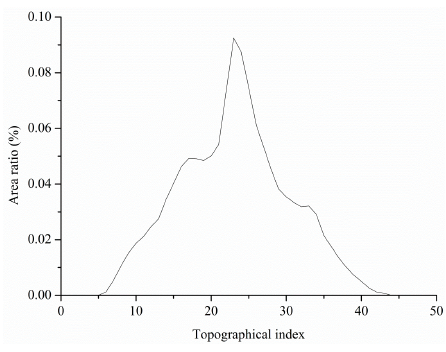
Figure 4. Relationship curve of the topographical index and area ratio.